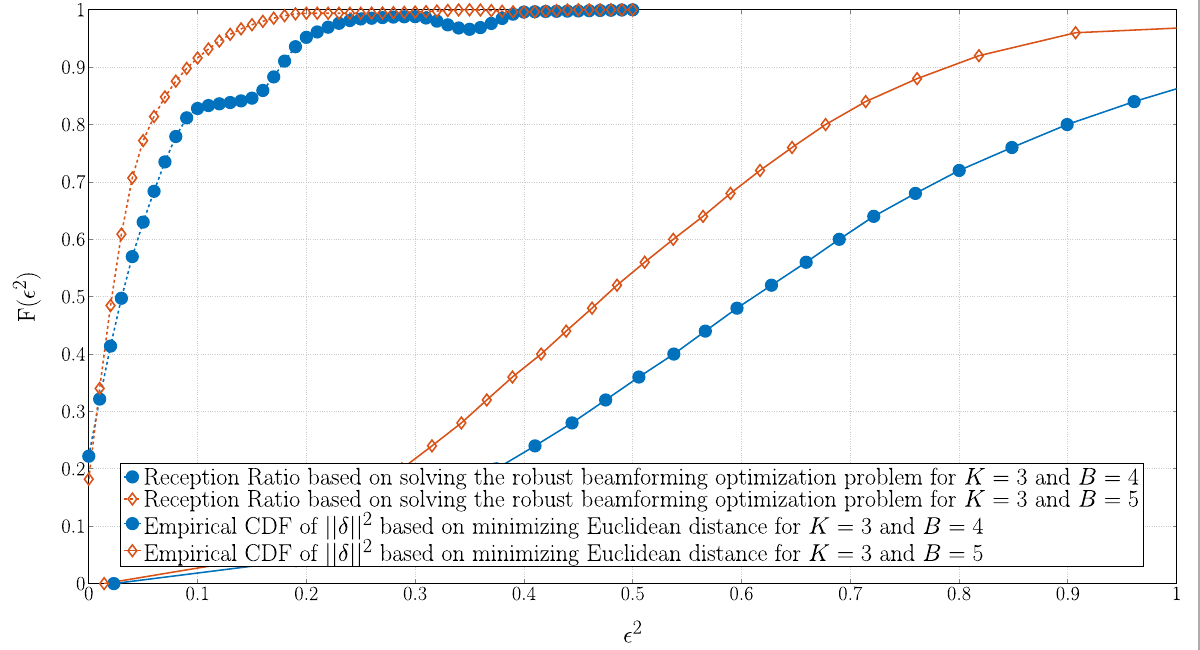
Fig. 7 Statistical vs actual reception ratio. Expected reception ratio based on empirical CDF of || δ || 2 and actual reception ratio after solving the robust beamforming optimization